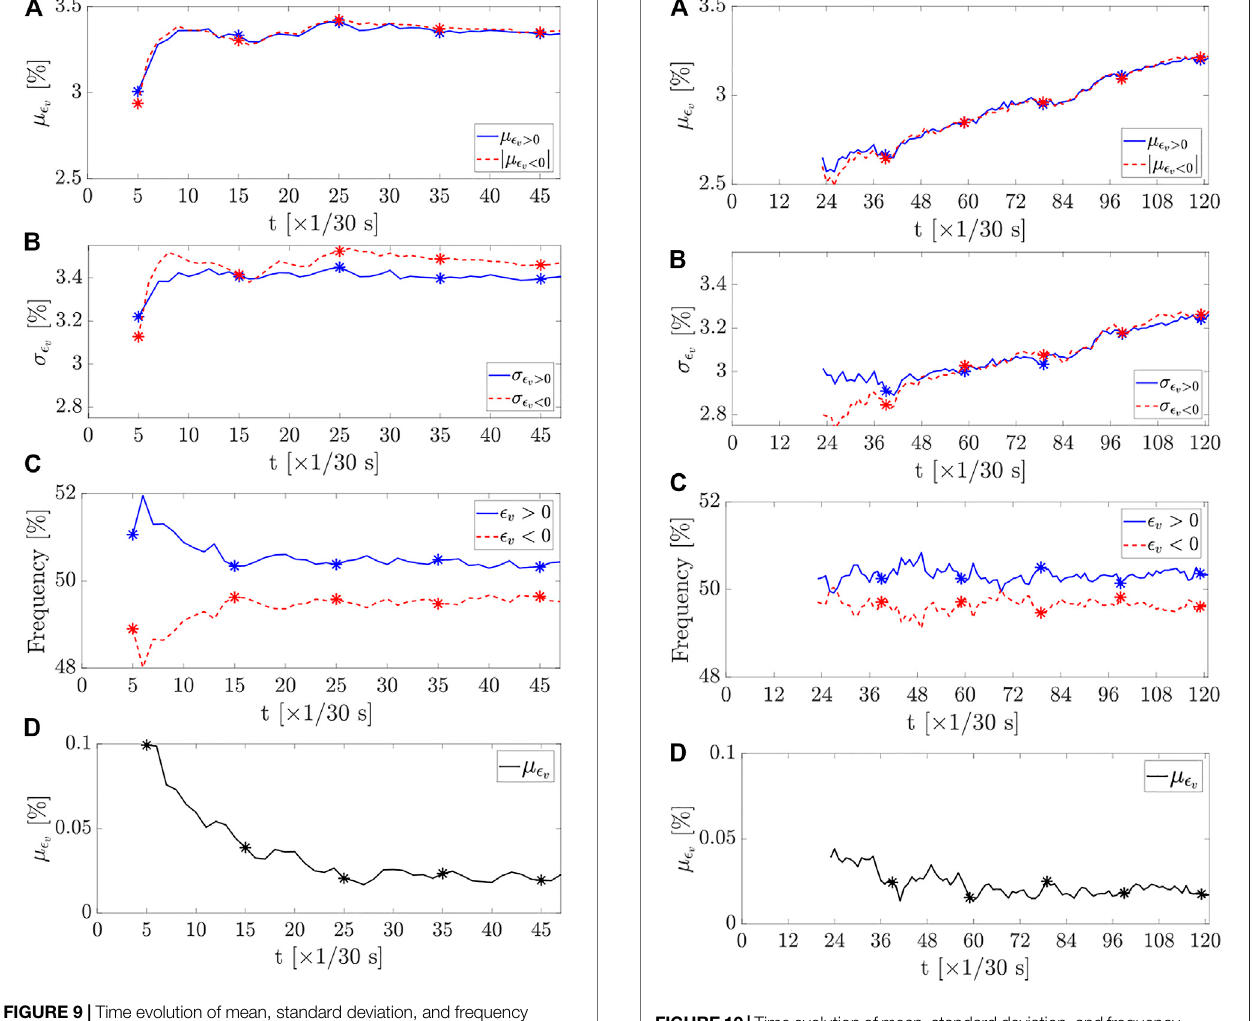
FIGURE10| Timeevolutionofmean,standarddeviation, andfrequency ofpositiveandnegativevolumetricstrainscapturedinsidethe fi nger (A,B) and (C) , respectively, and mean of volumetric strains inside the fi nger (D) for test (2). The time instants corresponding to the images of test (2) in Figure 7 are labeled bythesymbol*.The reference t 0 corresponds totheinstantofgas entering the